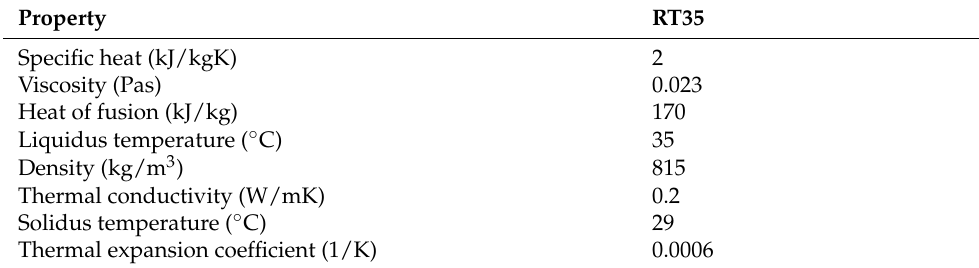
Table 1. Thermophysical properties of RT35